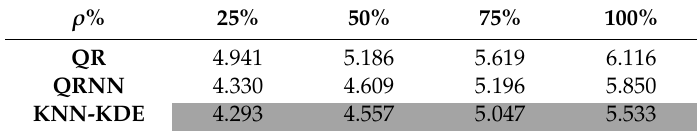
Table 3. QS values of three probabilistic forecasting models under various levels of false data attacks.